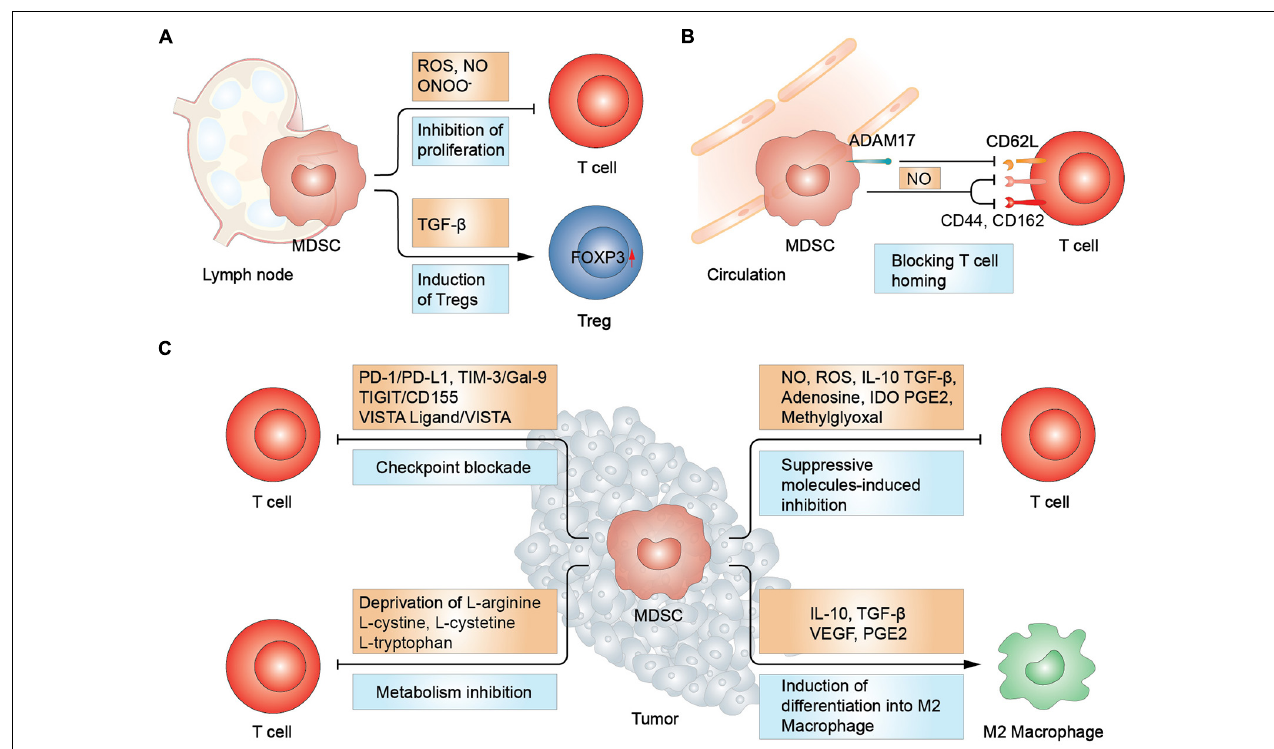
FIGURE 1 | MDSCs-mediated suppression in T cells. (A) In lymph node, MDSCs promote Treg differentiation and increase FOXP3 expression via TGF- β . T cell proliferation was inhibited due to the increased secretion of reactive oxygen and nitrogen spices. (B) MDSCs inhibit T cell homing by disrupting L-selectin (CD62L) structure and hindering the function of CD44 and CD162, essential in T cell homing. (C) In tumor sites, MDSCs inhibit T cells via immune checkpoint blockade, metabolism deprivation, and suppressive molecules. Moreover, MDSCs induce macrophage differentiation into type 2 macrophage (M2 macrophage). Treg, regulatory T cell; IDO, indoleamine